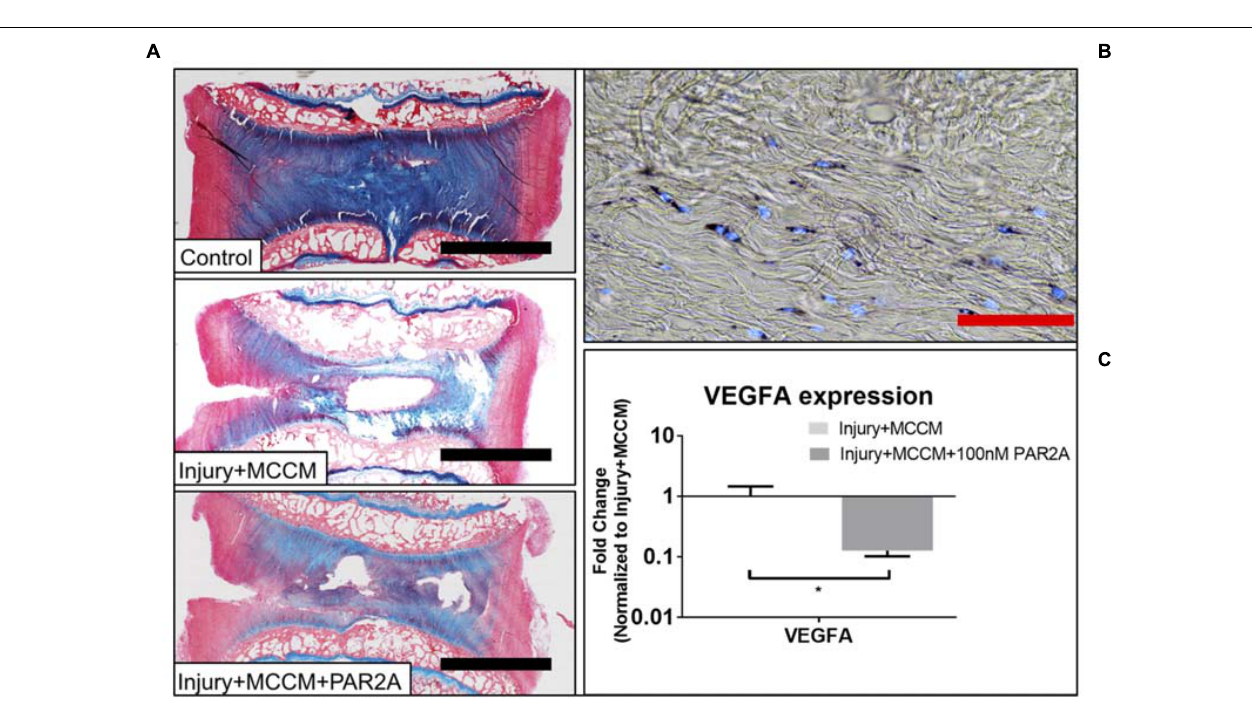
FIGURE 5 | (A) Representative Alcian blue (aggrecan) and picrosirius red (collagen) staining of bovine caudal IVDs after 96 h of culture. Discs were either left intact (control) or injured and cultured with MCCM with or with a PAR2A. (B) Representative cell viability image for Injury groups treated with MCCM + PAR2A. (C) Average fold change in qRT-PCR gene expression in AF region of bovine ex vivo samples ( ∗ p < 0.05). Red scale bar = 1000 µ m, Black scale bar = 50 µ